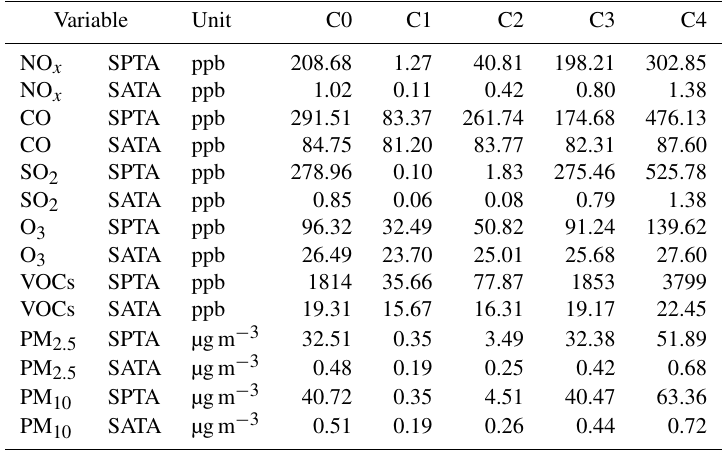
Table 8. Spatial average–temporal average (SATA) and spatial peak–temporal average (SPTA) of the concentration of trace gases and parti- cles, in the various scenarios ∗ .